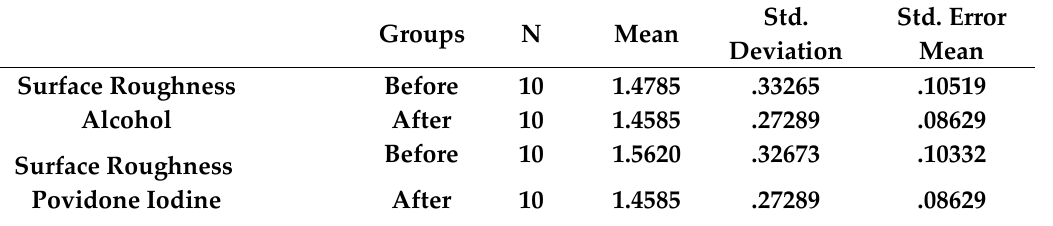
Table (3): : summary statistics of surface roughness test